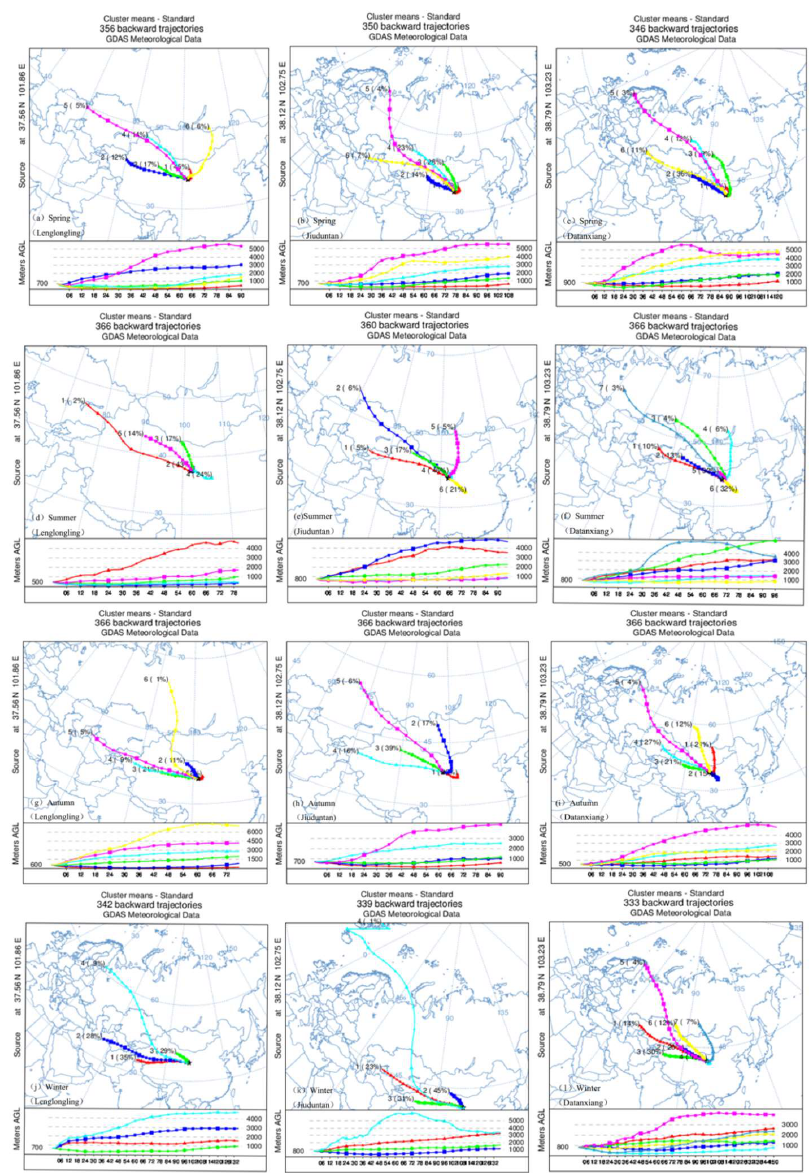
Figure 6. Cluster analysis of moisture sources in different seasons in the Shiyang River Basin based on the adjusted back trajectories: ( a – c ) Spring trajectory of moisture source: Lenglongling (upstream), Jiuduntan (midstream), Datanxiang(downstream); ( d – f ) Summer trajectory of moisture source: Lenglongling ( d ), Jiuduntan ( e ), Datanxiang ( f ); ( g – i ) Autumn trajectory of moisture source: Lenglongling ( g ), Jiuduntan ( h ), Datanxiang ( i ); ( j – l ) Winter trajectory of moisture source: Lenglongling ( j ), Jiuduntan ( k ), Datanxiang ( l ).